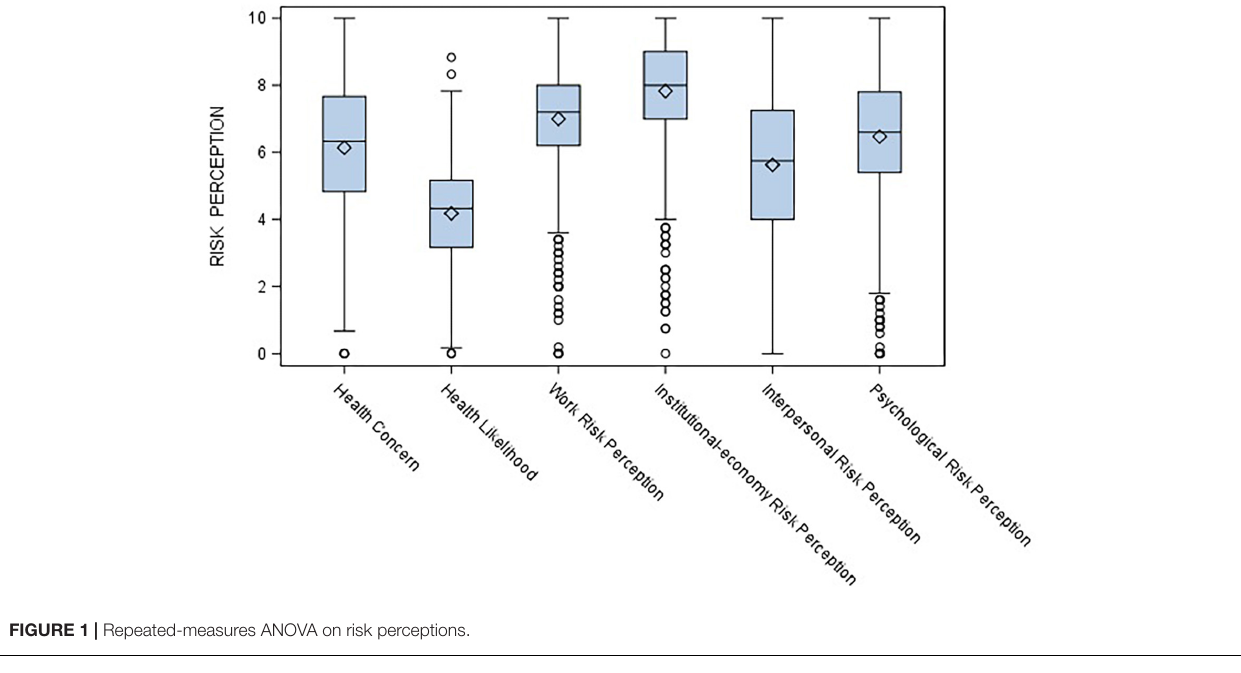
FIGURE 1 | Repeated-measures ANOVA on risk perceptions.